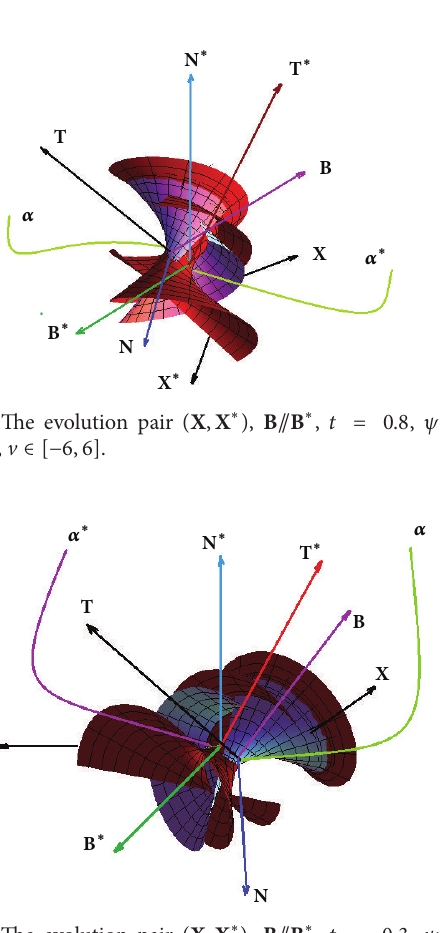
Figure 3: The evolution pair ( X , X ∗ ) , B U B ∗ , 𝑡 = 0.3 , 𝜓 = 1 , 𝑠 ∈ [−𝜋,𝜋] , V ∈ [−6,6]